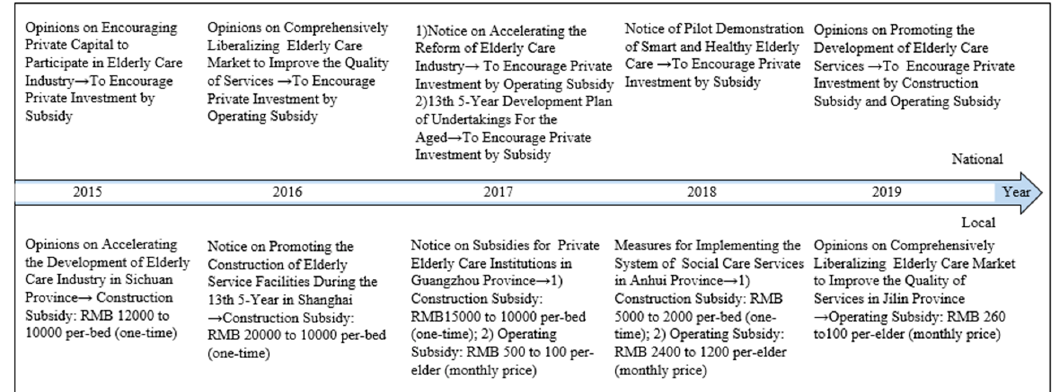
Figure 1. National and local governments’ incentives for private investors in the ECM in China [34–39].